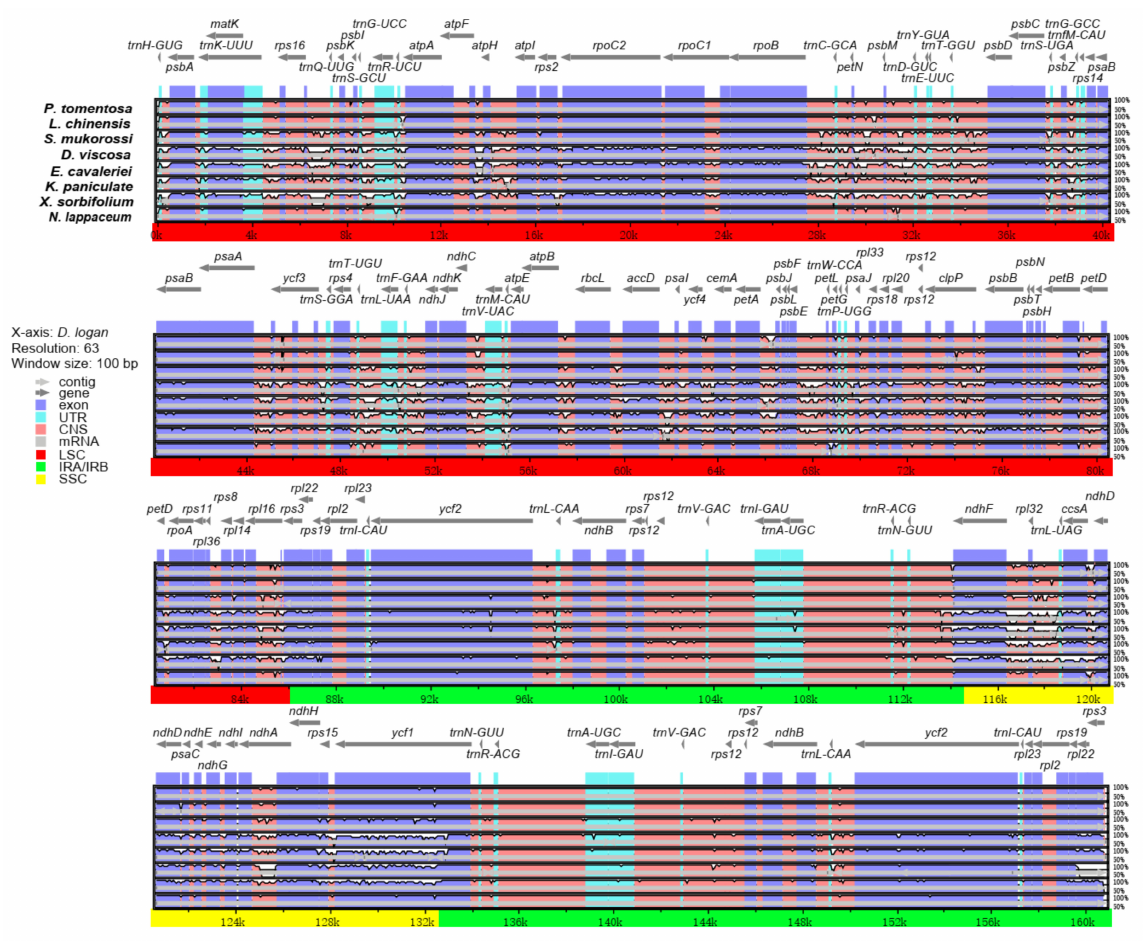
Figure 4. Comparison of nine Sapindaceae chloroplast genomes (including D. longan , L. chinensis , P. tomentosa , S. mukorossi , D. viscosa , E. cavaleriei , K. paniculata , X. sorbifolium and N. lappaceum ), with D. longan as a reference. Gray arrows and thick black lines above the alignment indicate the direction of the gene. Purple bars represent exons, blue bars represent untranslated regions (UTRs), pink bars represent conserved non-coding sequences (CNS), and gray bars represent mRNA. The y-axis indicates the identity, expressed as a percentage, between 50% and